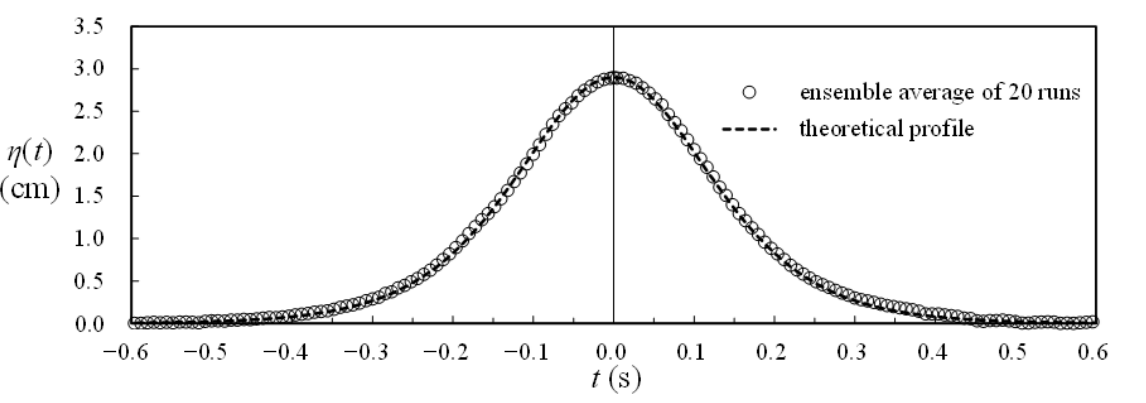
Figure 2. A comparison among five repeated runs for the original time series of free surface elevation η o ( t ) (Case E).